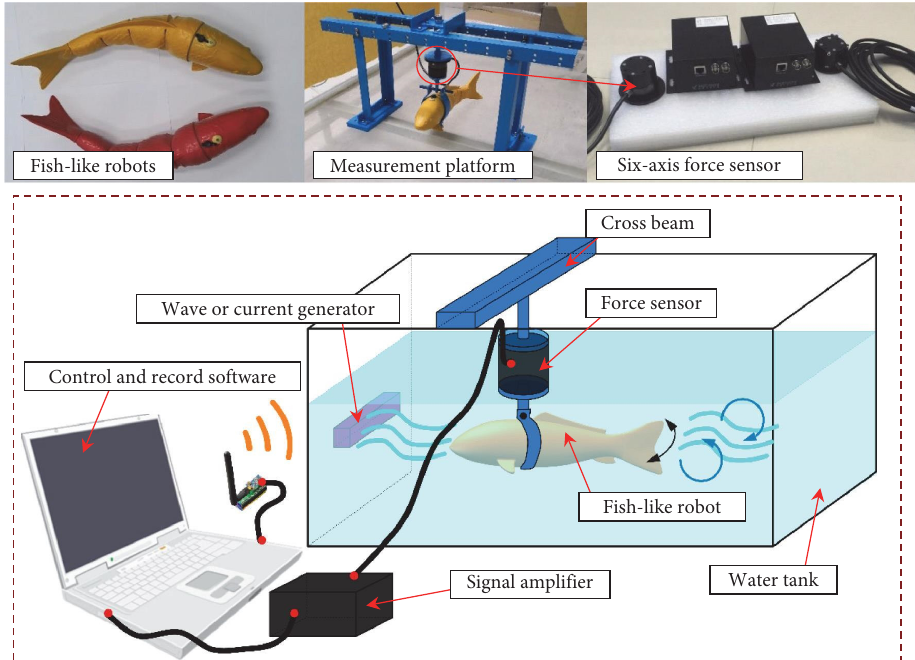
F IGURE 3: Experimental equipment and schematic diagram.